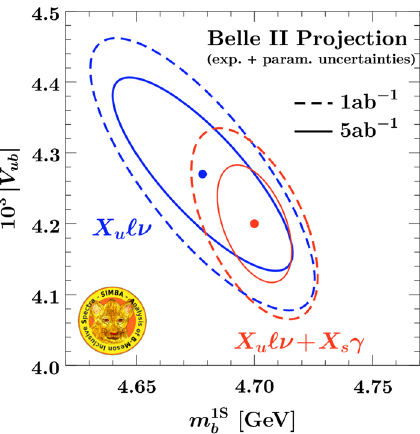
Fig. 10 Belle II projection for a global fit in the SIMBA approach of | V | with 1 ab − 1 and 5 ab − 1 . Theory uncertainties are not included ub